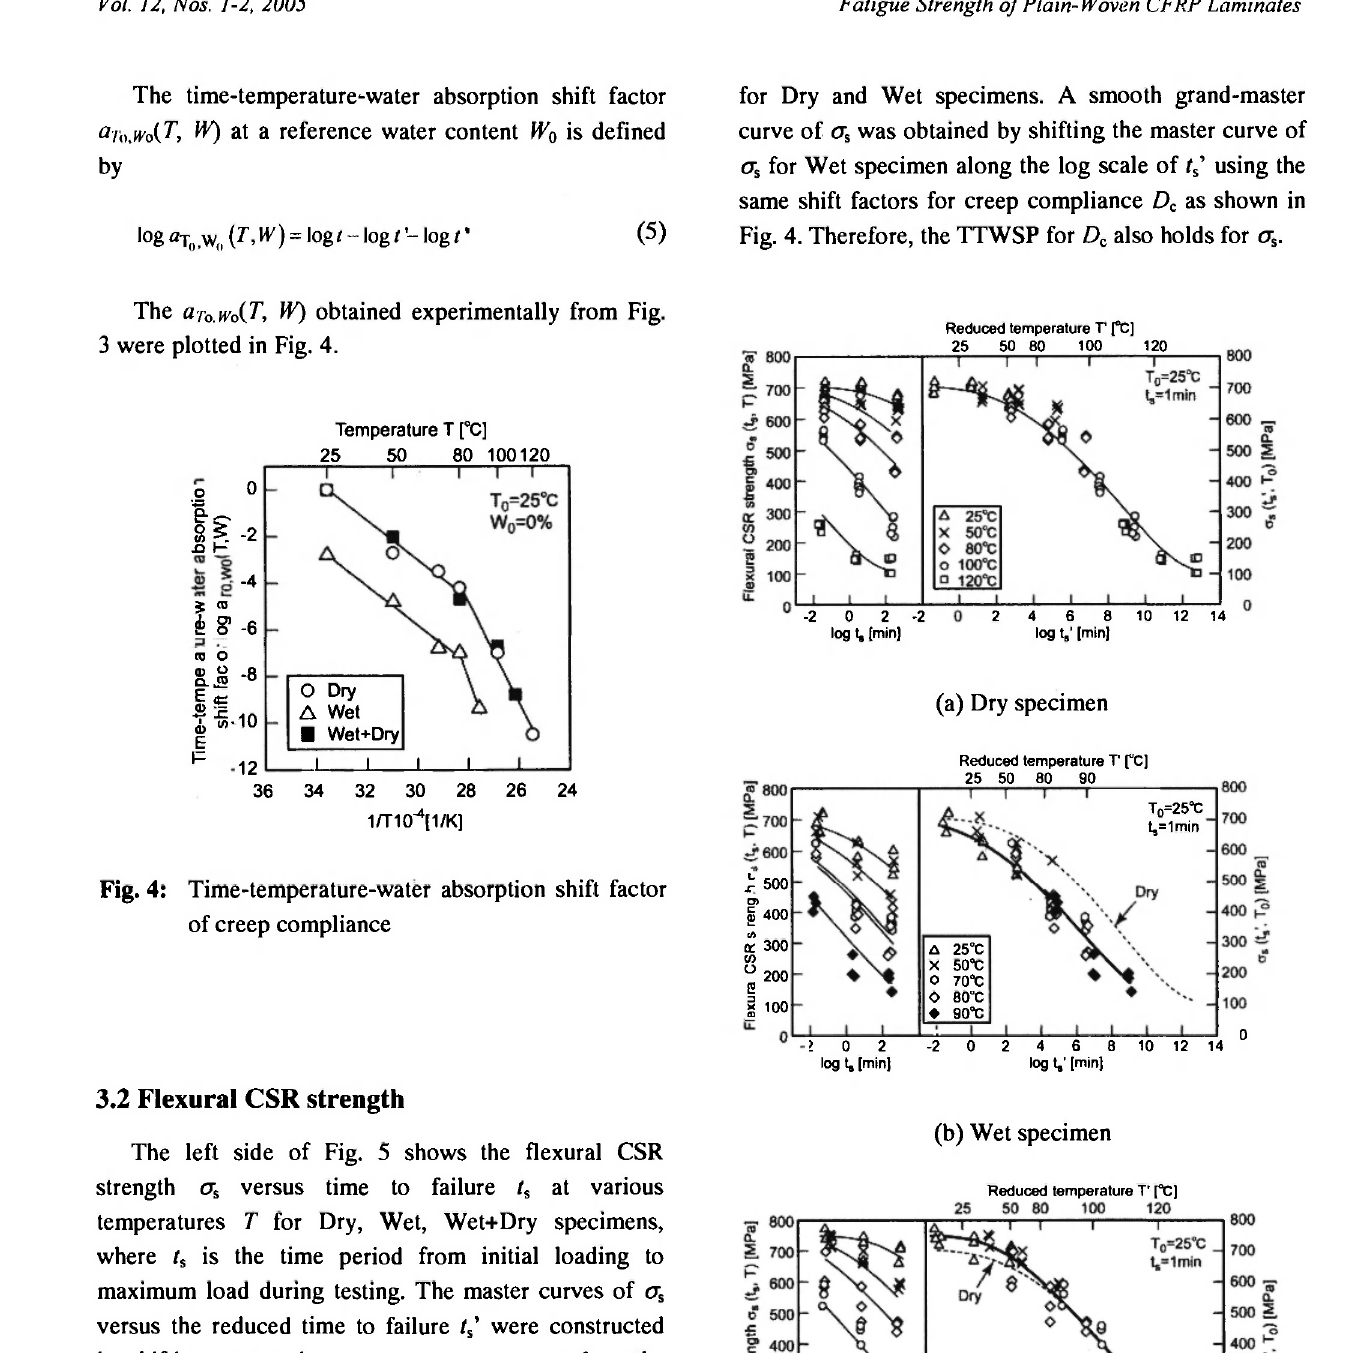
Fig. 4: Time-temperature-water absorption shift factor of creep compliance